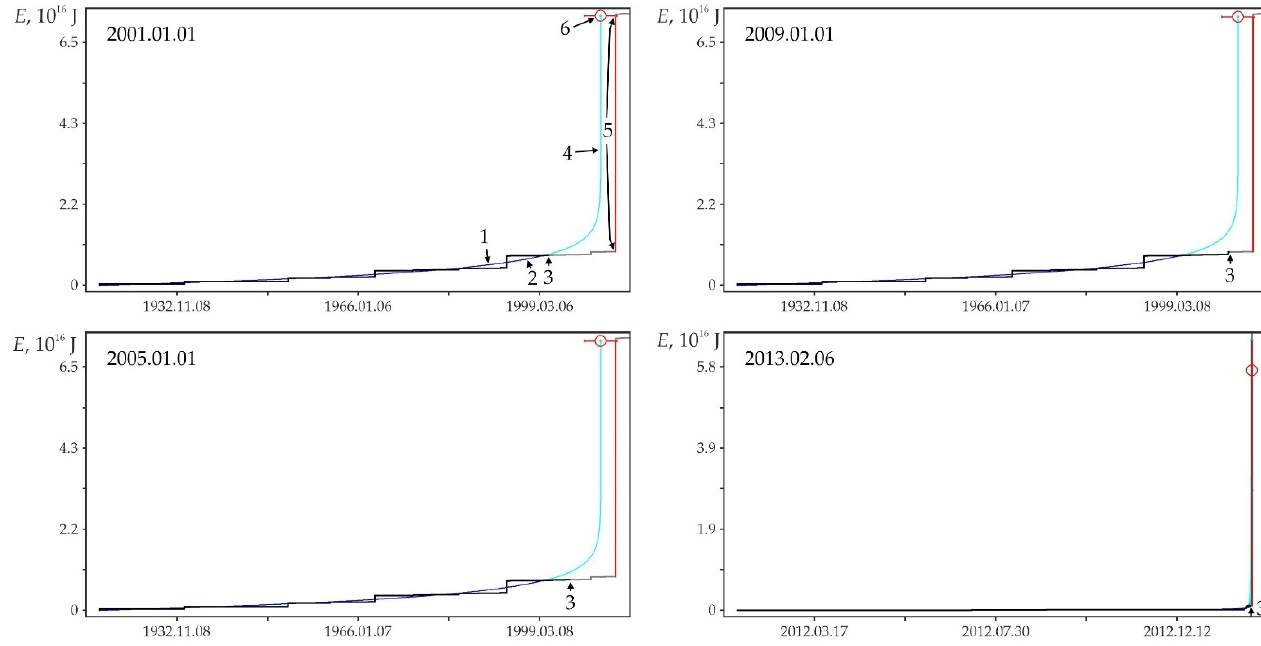
Figure A12. Retro predictability of the earthquake on 6 February 2013 in the zone with the highest (at the estimate date; see Figure A11, column ‘a’) number of successful predictive extrapolations (see Figure A4 for explanations). Table A9. Retro estimation of the place and time of earthquakes by clusters of precedent activity for earthquake 6 February 2013.